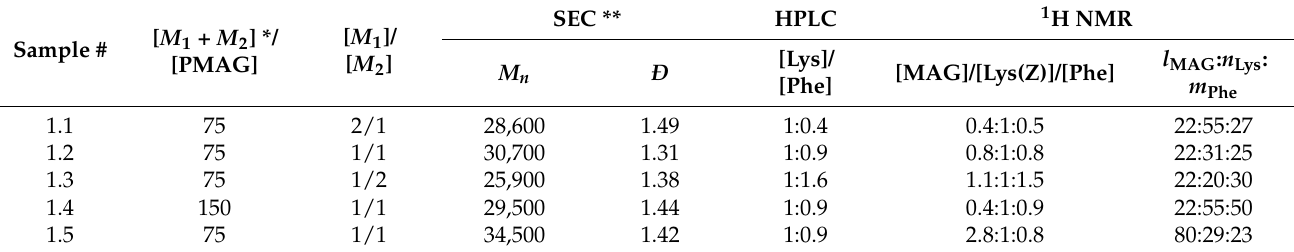
Table 1. The characteristics of synthesized amphiphilic PMAG l - b -P(Lys n - co -Phe m ).